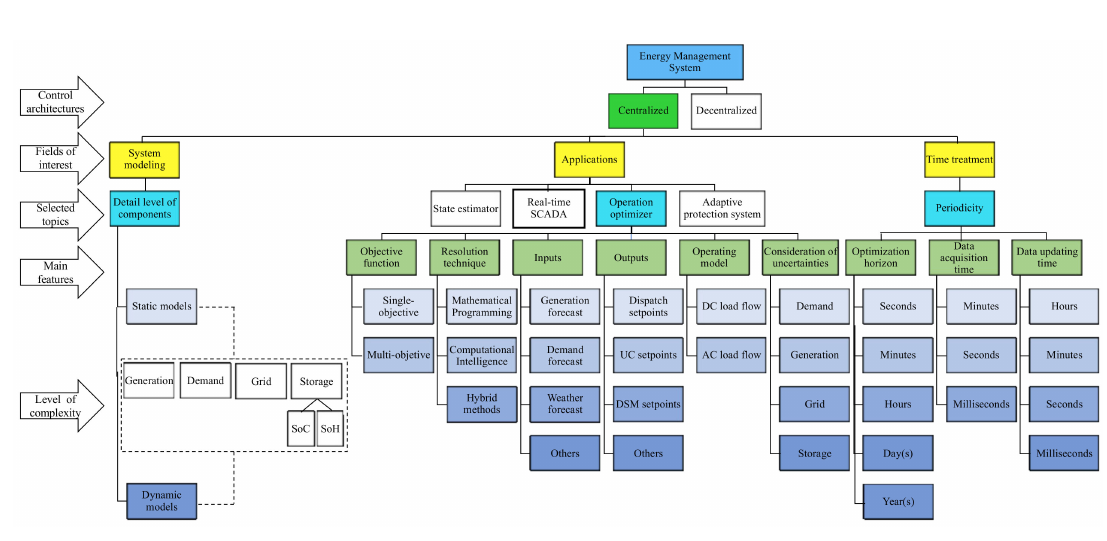
Figure 3. Analysis scheme proposed for the